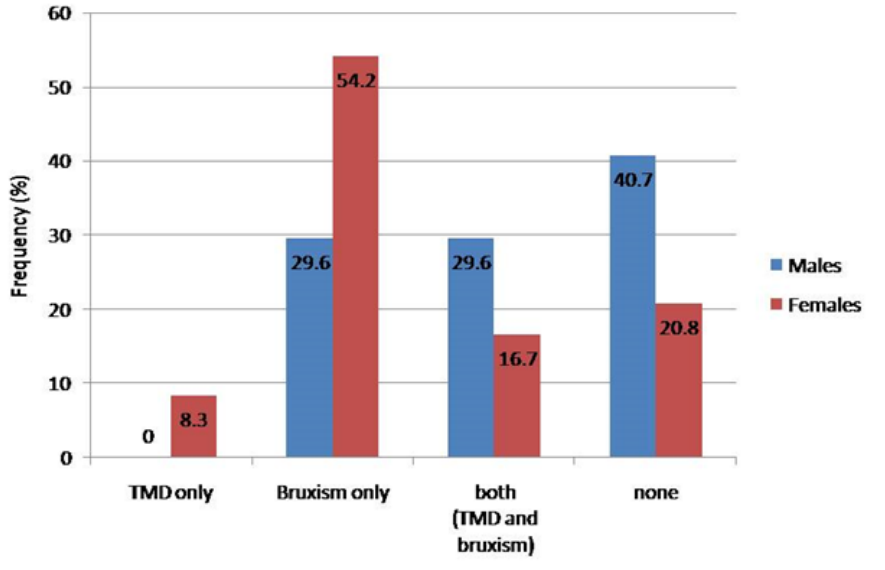
Figure 3. Prevalence of TMD/bruxism among studied sample.